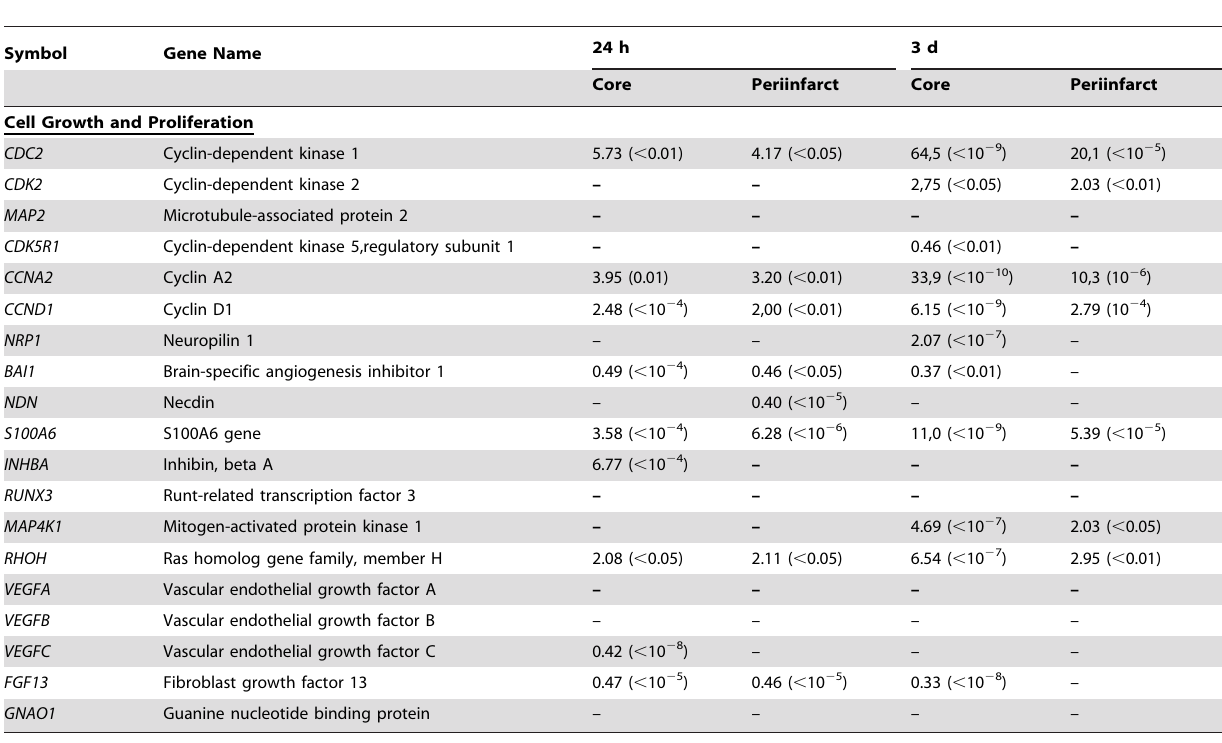
Table 4. Regulation of cell growth and proliferation-associated genes in the core and periinfarct after permanent focal cerebral